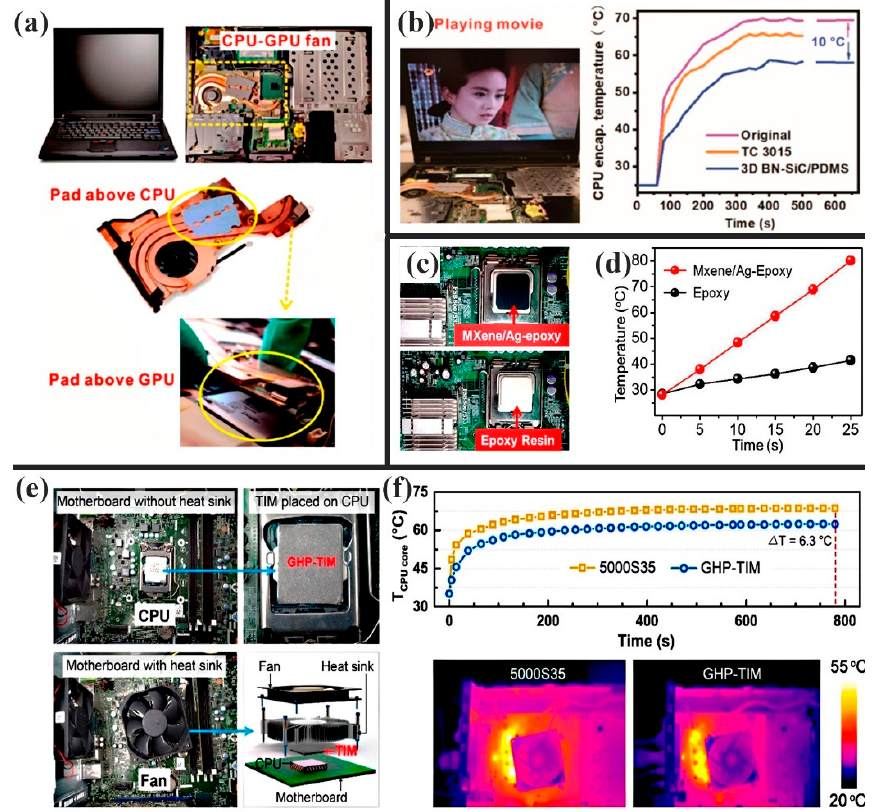
Figure 32. ( a ) Diagrams of CPU-GPU integrative fan, thermal pads above CPU and GPU, respectively. ( b ) The measured CPU encapsulation temperature with different materials (reproduced with permission from [206]). ( c ) Two films were used as TIMs, respectively. ( d ) Variation in temperature as a function of time (reproduced with permission from [165]). ( e ) Two materials were used as TIMs. ( f ) CPU core temperature evolution as a function of running time and IR images of the 5000S35 and GHP used as TIMs (reproduced with permission from [201]).